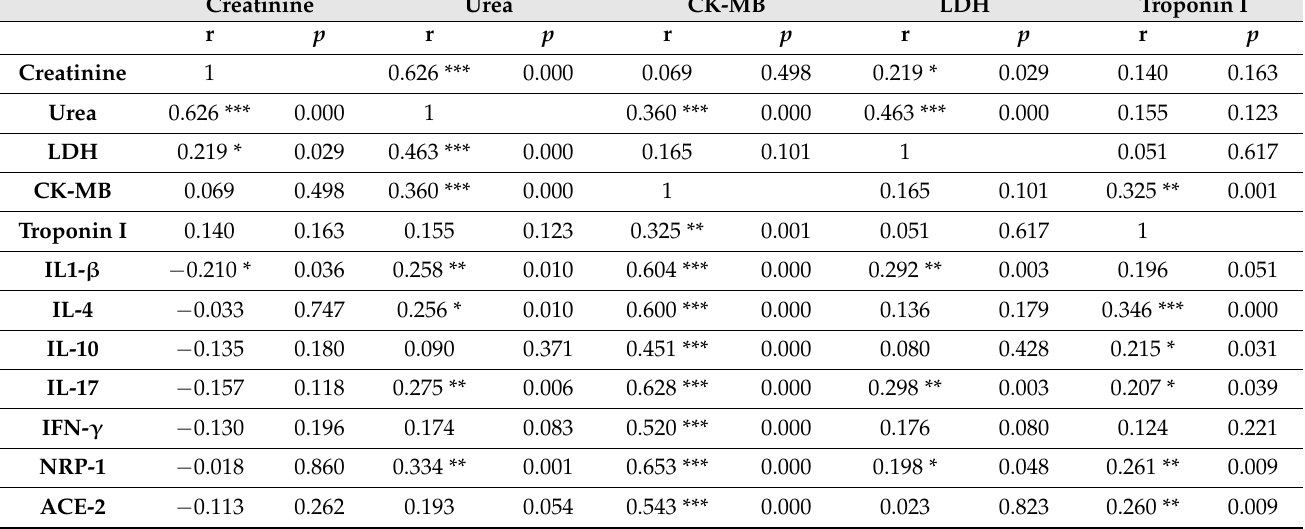
Table 2. Correlations between kidney and heart function biomarkers, cytokine levels and ACE-2 and NRP-1 expression levels in the moderate group.